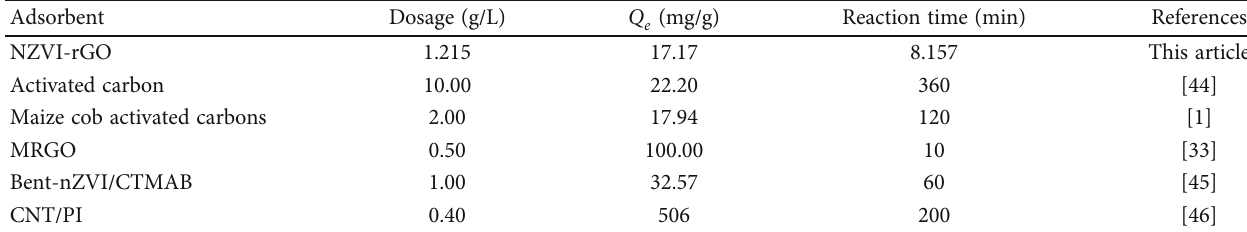
Table 5: Comparison of the adsorption capacities for 2,4-DCP onto various